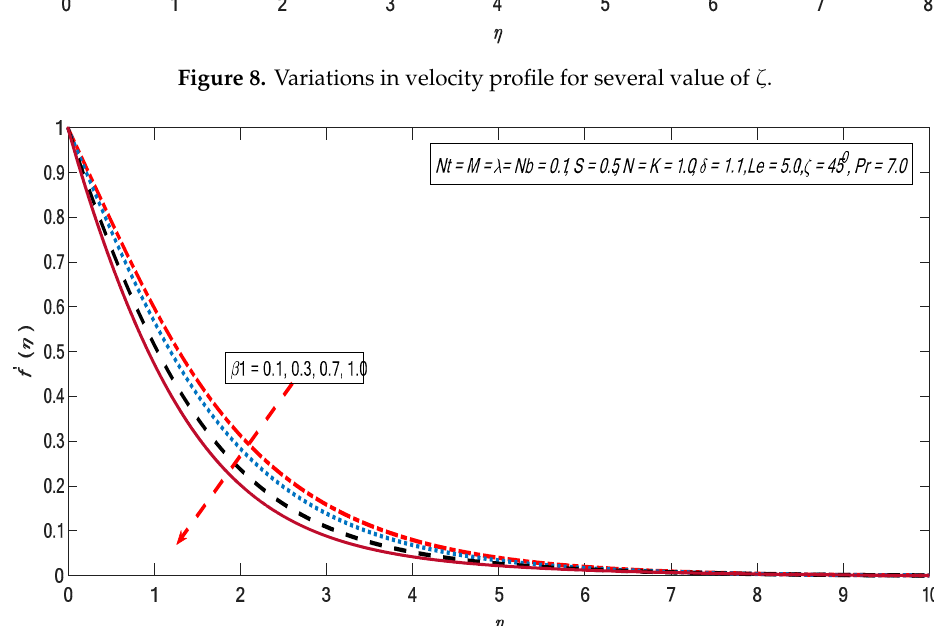
Figure 9. Variations in velocity profile for several value of 𝛽 (cid:2869) .